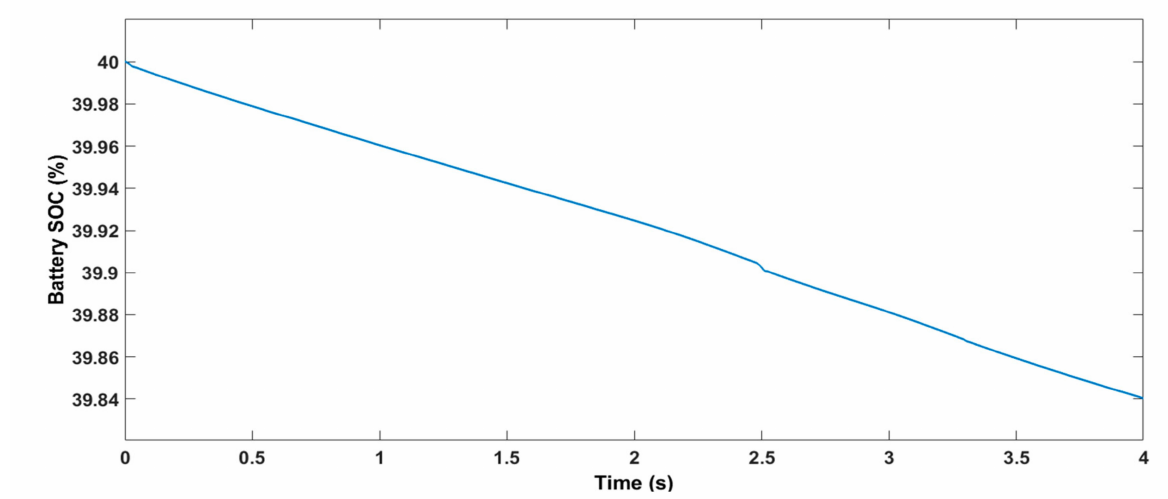
Figure 21. Battery’s state of charge (SOC) during